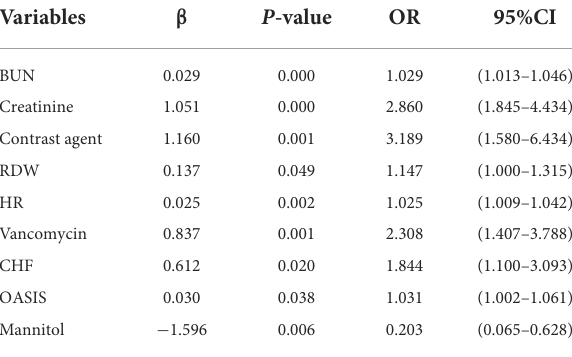
TABLE 4 Multivariate logistic regression analysis of candidate factors of acute kidney injury (AKI) in the training